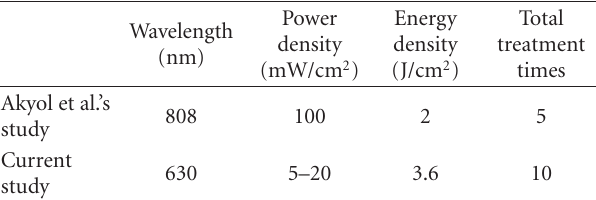
Table 3: The di ff erences of the laser treatment parameters in two studies.